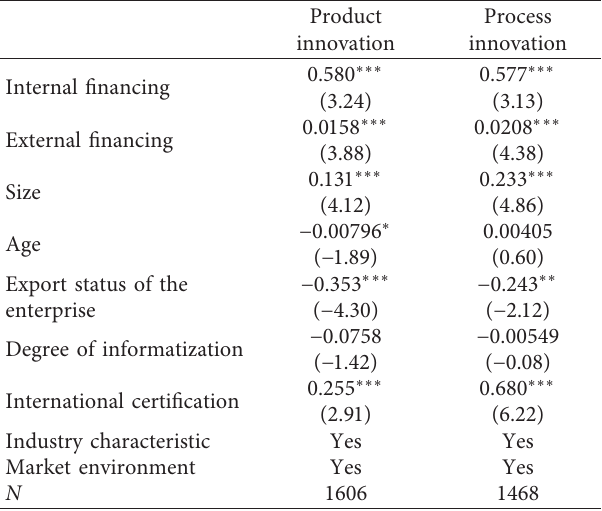
Table 7: Specific financing methods and technological innovation of